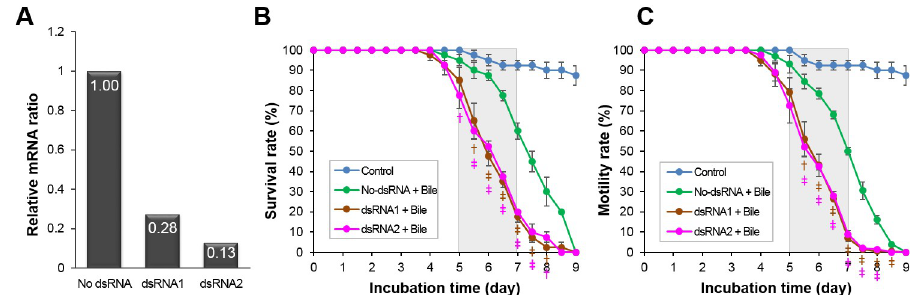
Fig 7. Effect of CsSBAT silencing using RNAi. (A) Downregulation of CsSBAT transcripts measured using RT-qPCR. No dsRNA, flukes incubated without dsRNA; dsRNA1 and dsRNA2, flukes incubated in CsSBAT-dsRNA1 or CsSBAT-dsRNA2. (B) Survival and (C) motility of Clonorchis sinensis adults incubated in CsSBAT-dsRNA1 or CsSBAT-dsRNA2 plus 0.075% bile solution. In control groups, C . sinensis were incubated in 1 × Locke’s solution or plus 0.075% bile solution. Data represent mean ± standard error. † p < 0.05, ‡ p < 0.01, compared to flukes in the bile only.